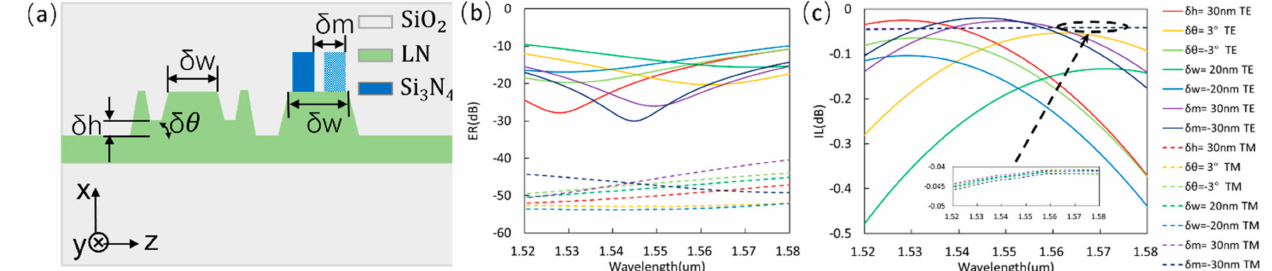
Figure 5. ( a ) Four parameters of manufacturing tolerance. ( b ) ERs and ( c ) ILs of the device with parameters deviating from the optimized